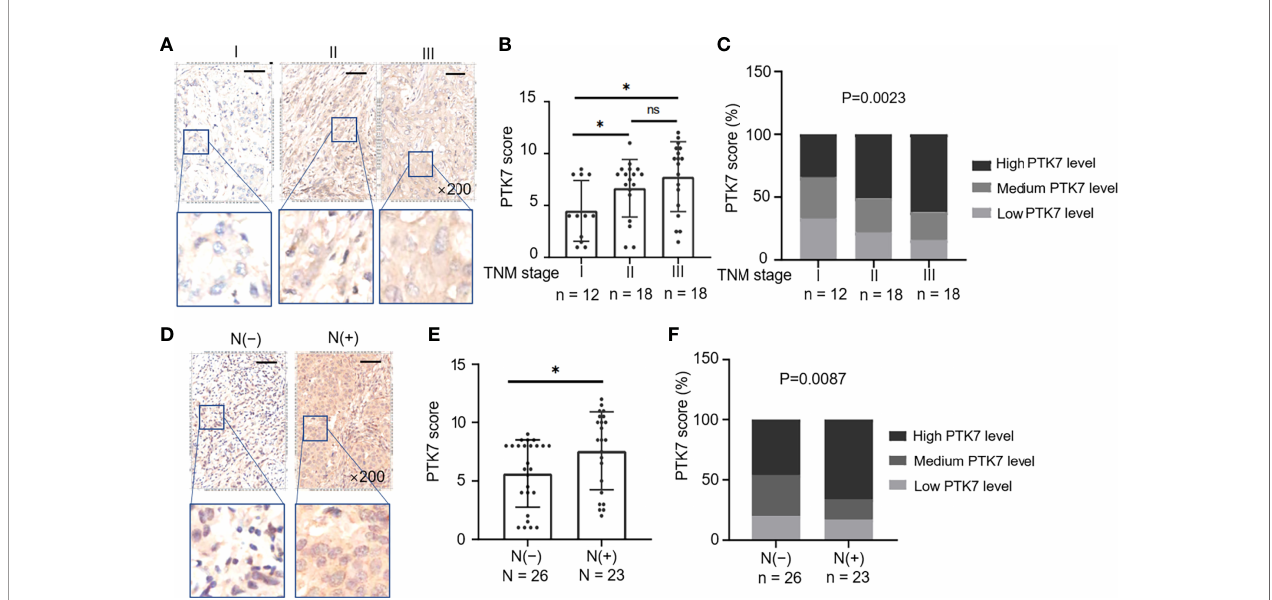
FIGURE 3 | Upregulation of PTK7 is related to metastasis and TNM stage in TNBC. (A) TNBC samples from 280 subjects of breast cancer tissue microarray were selected and divided into three groups based on TNM stages (AJCC staging). Representative images of IHC staining of PTK7 expression in the three groups (stage I, II and III) are shown. Magni fi cation, ×200; scale bars, 100 m m. (B) Scatter dot plots of PTK7 scores in the three groups described in (A) . Data were analyzed using one-way ANOVA and are shown as mean ± s.d. * P < 0.05. (C) The percentage of cases in the groups described in (A) . Data were analyzed using Pearson ’ s c 2 test. Light grey, low PTK7 level (IHC score 0~4); dark grey, medium PTK7 level (IHC score 5~8); black, high PTK7 level (IHC score 8~12). (D) TNBC samples were divided into two groups based on lymph node metastasis. Representative images of PTK7 staining in TNBC with or without lymph node metastasis are shown. Magni fi cation, ×200; scale bars, 100 m m. (E) Scatter dot plots of PTK7 scores in the two groups described in (D) . Data were analyzed using one-way ANOVA and are shown as mean ± s.d. * P < 0.05. (F) The percentage of cases in the groups described in (D) . Data were analyzed using Pearson ’ s c 2 test. Light grey, low PTK7 level (IHC score 0~4); dark grey, medium PTK7 level (IHC score 5~8); black, high PTK7 level (IHC score 8~12). ns, no signi fi